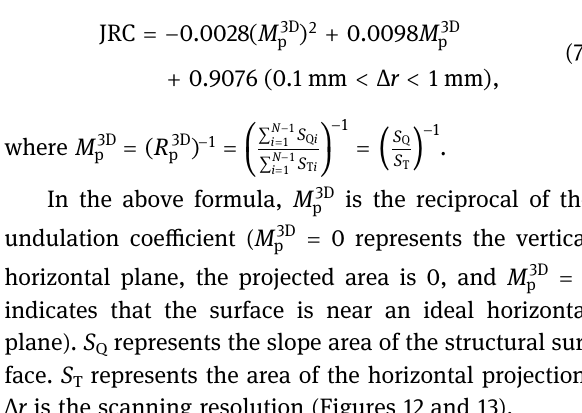
Table 2: Geometric parameters of the structural plane at di ff erent resolutions